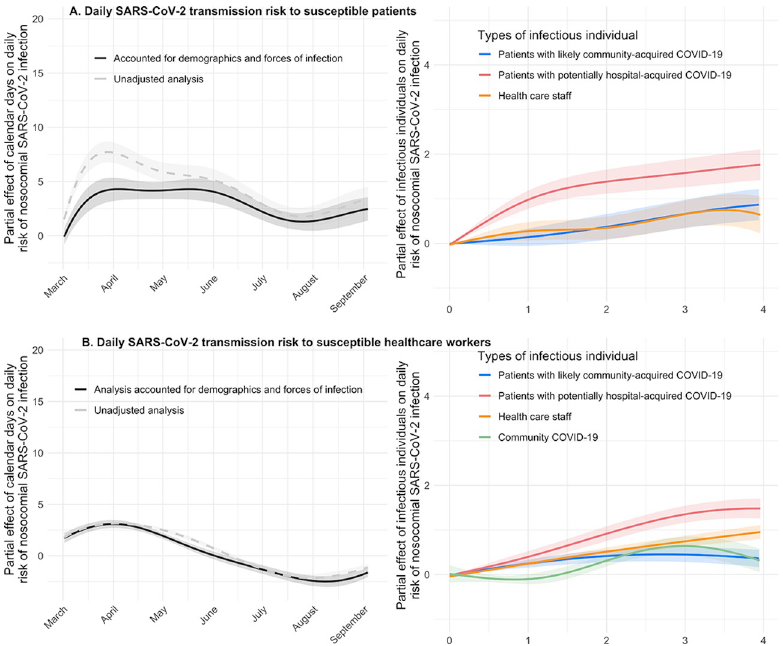
Fig 3. Daily transmission risk to susceptible patients (Panel A) and HCWs (Panel B) using a generalised additive model with a logit link. The smooth, nonlinear partial effects of calendar day, infectious patients, and HCWs on the daily risk of nosocomial SARS-CoV-2 infection are presented as coloured lines. These partial effects are the isolated effects of each group of infectious individuals on the binary outcome of assumed acquisition (yes/no) on each day as the dependent variable. Infectious patients and HCWs were both associated with increased risk of nosocomial infection. The presence of more infectious patients or HCWs in a ward on a given day was associated with higher transmission risk. COVID-19, Coronavirus Disease 2019; HCW, healthcare worker; SARS-CoV-2, Severe Acute Respiratory Syndrome Coronavirus 2.